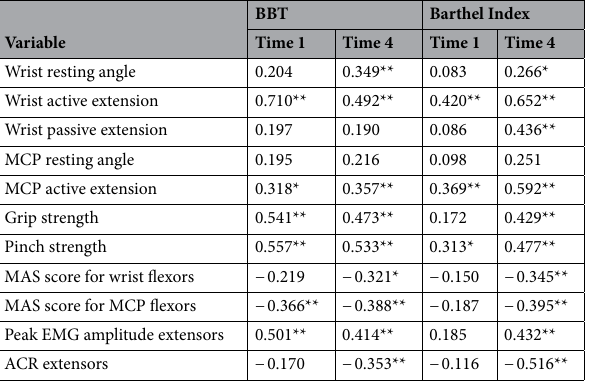
Table 6. Correlations among the motor impairment variables and the functional outcome measures. *p < .05; ** p < .01; BBT Box and Block Test, MCP Metacarpophalangeal; MAS Modified Ashworth Scale, ACR Co-activation ratio of the